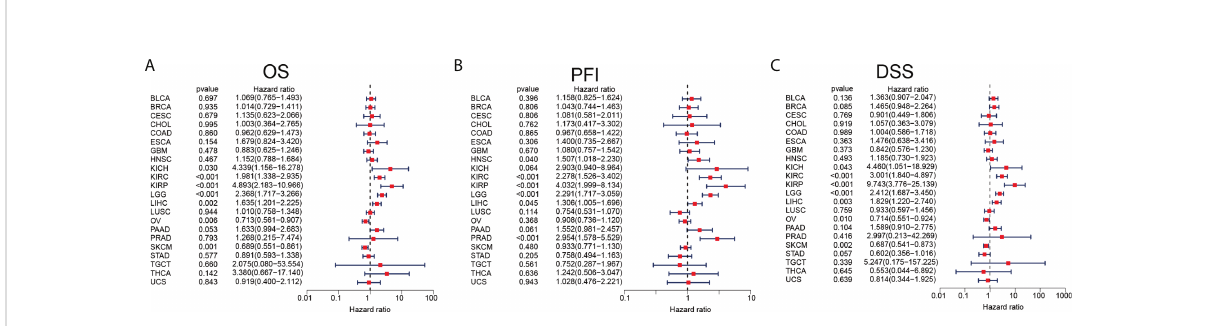
FIGURE 3 Prognosis analyses of ARPC5 in pan-cancer based on univariate Cox regression method. (A) The correlation between ARPC5 expression and OS. (B) The correlation between ARPC5 expression and PFI. (C) The correlation between ARPC5 expression and DSS. OS: overall survival; PFI: progression-free interval; DSS: disease-speci fi c survival.